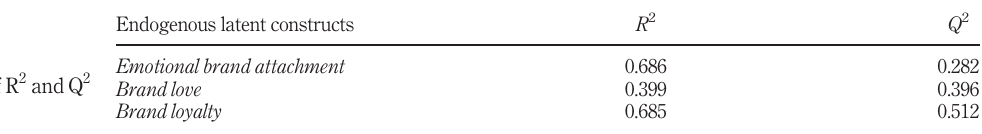
Table 4. Results of R 2 and Q 2